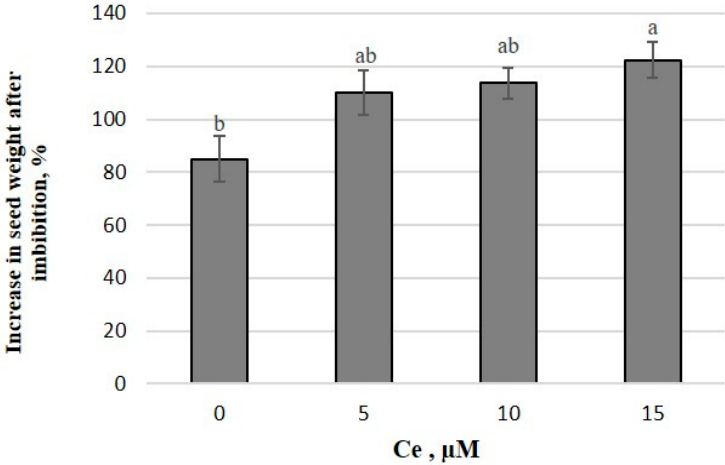
Figure 1. Percent increase in tomato ( Solanum lycopersicum L.) cv. Vengador seed weight after 12 h imbibition in Ce solutions. Means ± SDs with different letters indicate significant statistical differences among treatments (LSD, 0.05).